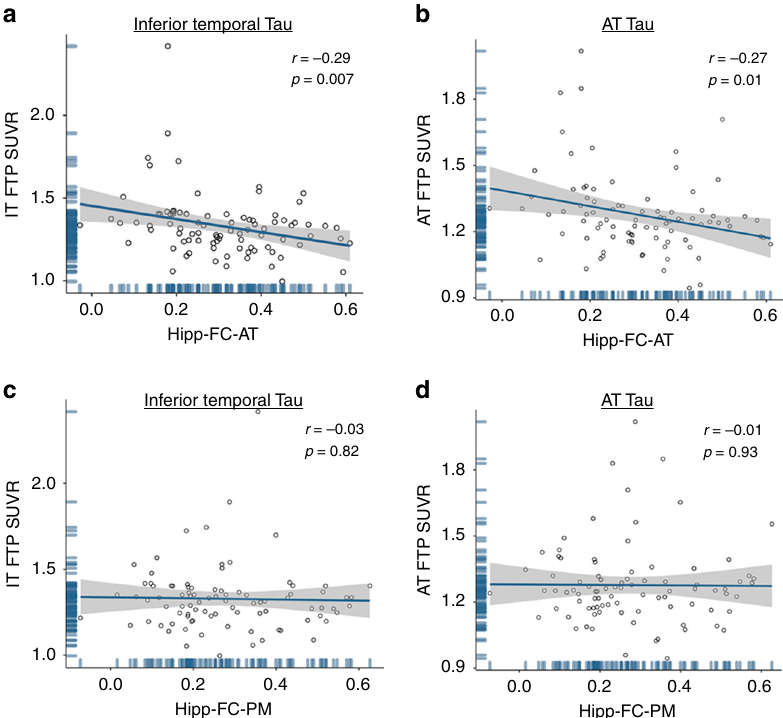
Fig. 5 Hippocampal FC is related to tau outside the MTL. a Hipp-FC-AT, measure of hippocampal connectivity to AT regions, negatively predicted IT FTP SUVR ( r = − 0.29, p = 0.007; all r and p -value pairs re fl ect Pearson correlation;). Hipp-FC-AT remained a signi fi cant predictor of FTP SUVR in IT ( p = 0.04; multiple regression) after adjusting for age, sex, hippocampal volume and hipp-ReHo. b Hipp-FC-AT was a negative predictor of AT Tau SUVR ( r = − 0.27, p = 0.01). After adjusting for covariates, hipp-FC-AT predicted AT FTP SUVR at statistical trend level ( p = 0.06; multiple regression). c , d There was no relationship between Hipp-FC-PM and IT FTP SUVR ( r = − 0.03, p = 0.82) or AT FTP SUVR ( r = − 0.01, p = 0.93). Source data are provided as a Source Data fi le. IT inferior temporal cortex, FTP fl ortaucipir, SUVR standardized uptake value ratio, AT anterior temporal, PM posterior medial, hipp-FC-AT hippocampal functional connectivity to tau-vulnerable AT regions, hipp-FC-PM hippocampal functional connectivity to A β -vulnerable PM regions